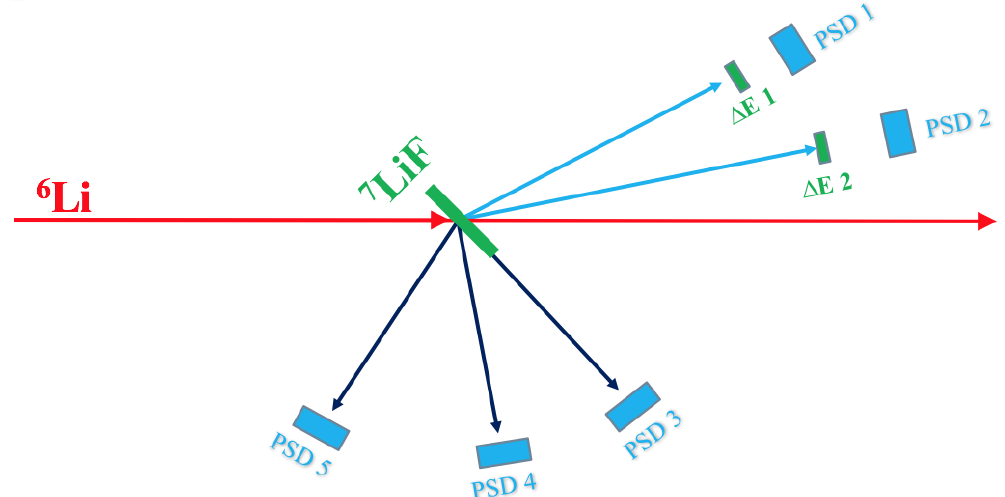
Figure 1. Sketch of the experimental set-up